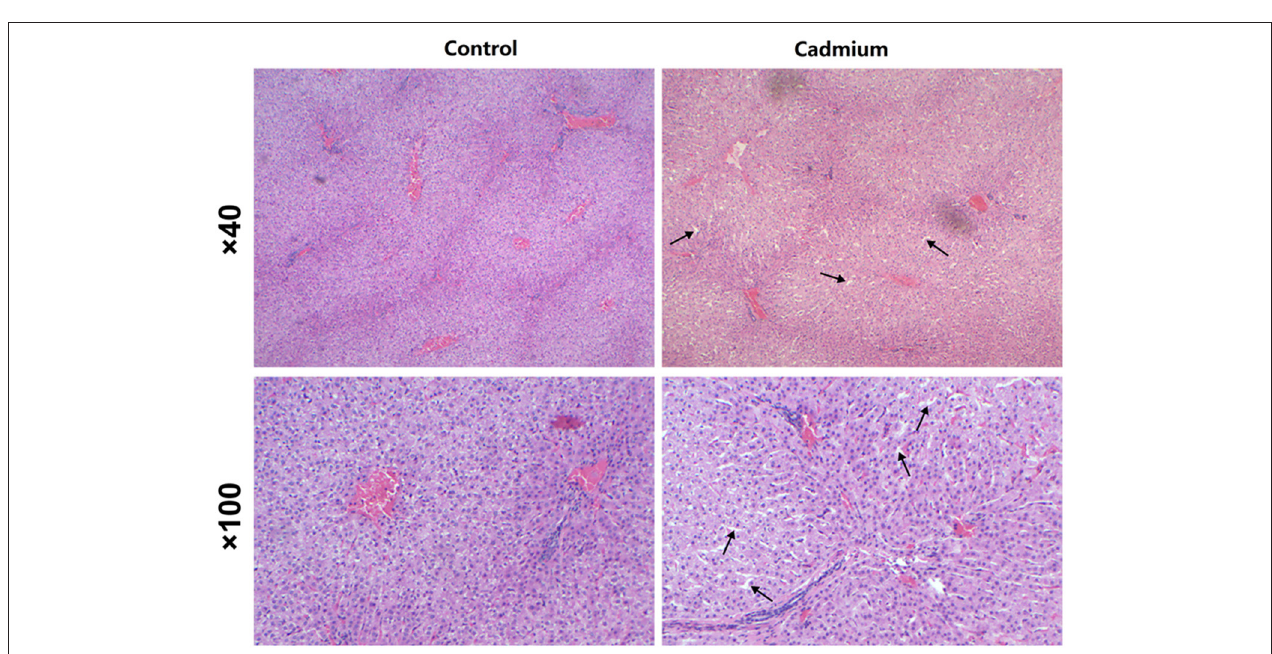
FIGURE 2 | H and E staining. Pathological changes in the liver of control heifers (Control) and cadmium-treated heifers (Cadmium) by H and E staining (40 × , 100 × ). Arrows indicate expanded hepatic sinusoids.